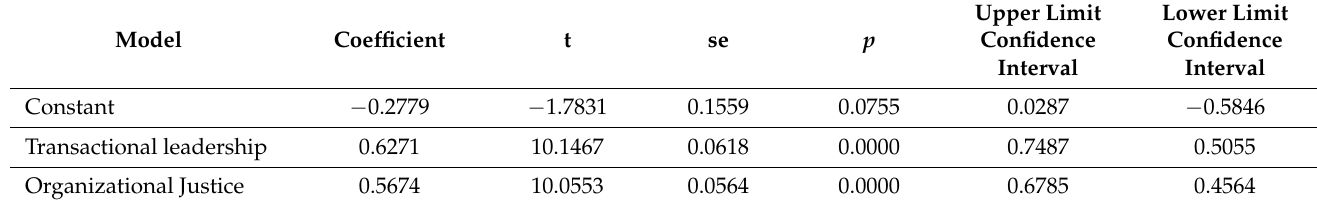
Table 14. The Coefficients of Regression (b and ´c).